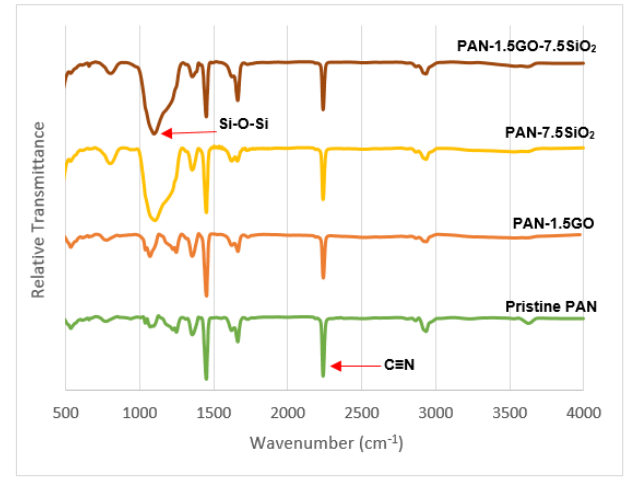
Figure 4. FTIR spectroscopy of developed membranes.